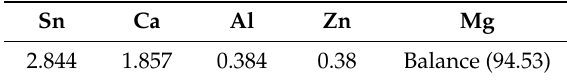
Table 1. The chemical composition (in percent) measured on the cast billet of TXAZ3200 alloy.